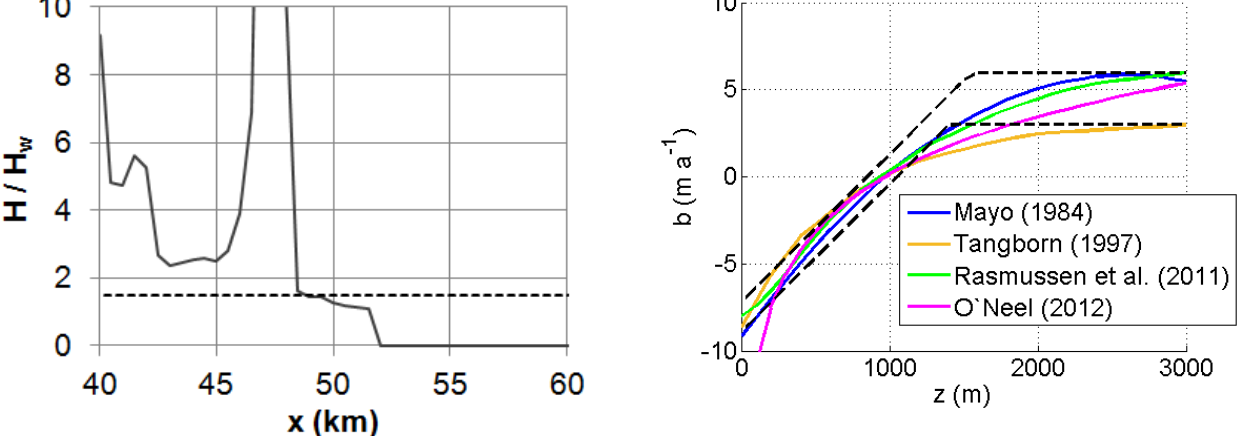
Fig. 5. Observed relation between surface mass balance rate ( b) and elevation ( z) at Columbia Glacier (solid lines; Mayo, 1984; Tang- born, 1997; Rasmussen et al., 2011; O’Neel, 2012), and the param- eterized range used in this study (dashed lines; Eq.